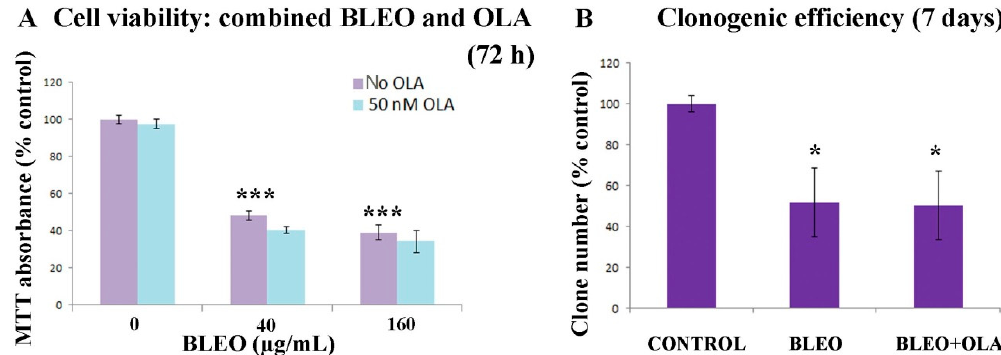
Figure 1. Neither the cell viability loss nor clonogenic efficiency loss induced by BLEO in VERO cells were potentiated by OLA. ( A ) Cell viability (MTT assay). Cells were exposed to BLEO and, when indicated, co- and post-exposed to 50 nM OLA. The result was evaluated after 72 h. Most experiments were carried out using 40 µg/mL BLEO and 50 nM OLA. The respective n ’s were as follows. No OLA: 63, 72, and 22; 50 nM OLA: 75, 86, and 12 (see Figure A2 for 150 nM OLA). ANOVA ( p = 1.11 × 10 − 16 ). Post-hoc tests: Tukey, Scheffe, and Bonferroni. ***: p < 0.001. ( B ) Clonogenic efficiency of VERO cells in the control condition or under a pulse treatment with 40 µg/mL BLEO (45 min) in the absence or presence of continuous treatment with 50 nM OLA. Data were from two independent experiments in triplicate. All results are expressed as mean ± SEM. Comparisons against control. ANOVA ( p = 0.0371) and Holm p -value with only comparisons against the control considered. *: p < 0.05.